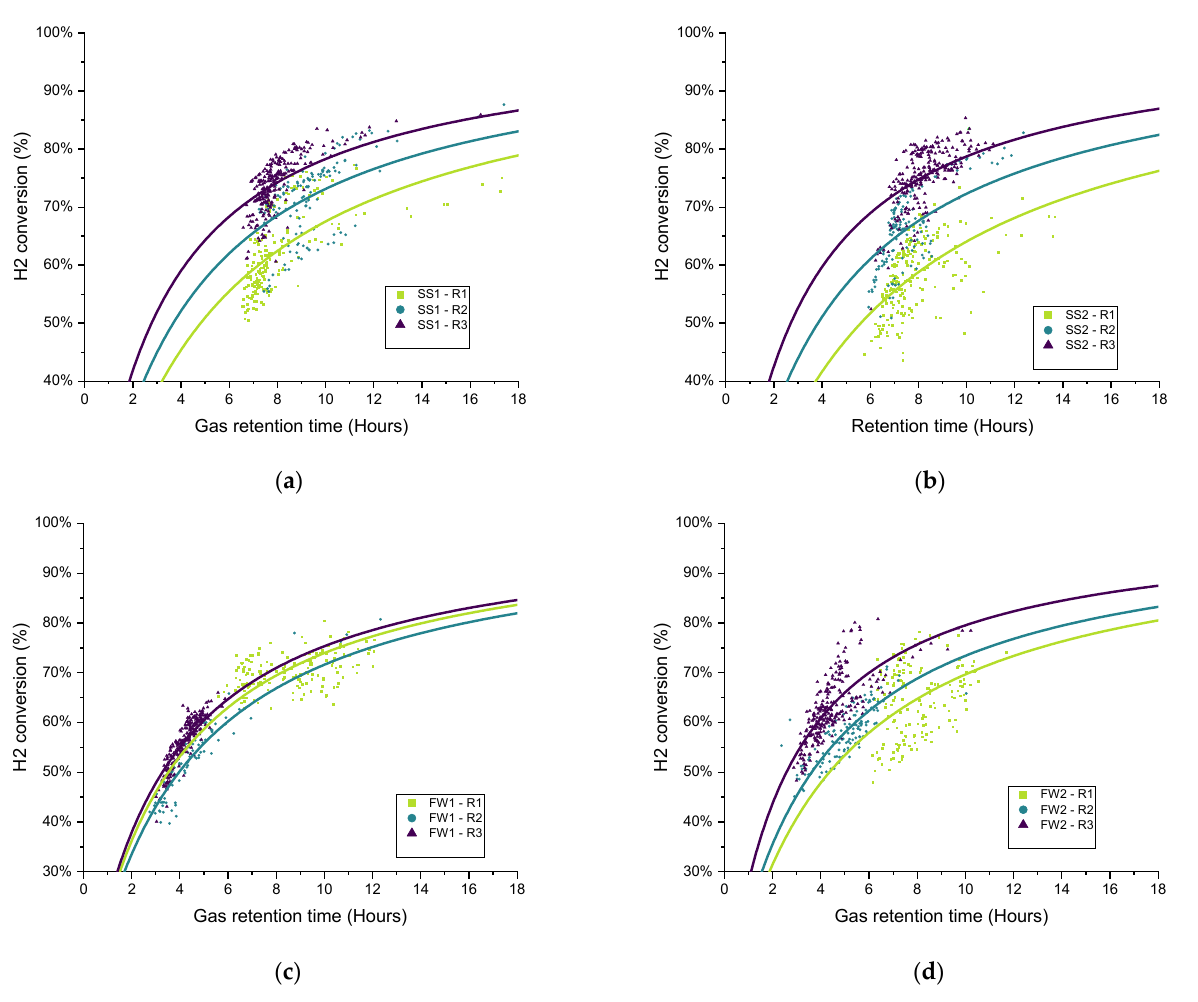
Figure 11. Scatter plot of the retention time and hydrogen conversion (two-hour period averages) with variations in biogas recirculation rate (R1–R3) for all biomethanation reactors: ( a ) SS1, ( b ) SS2, ( c ) FW1, and ( d ) FW2.